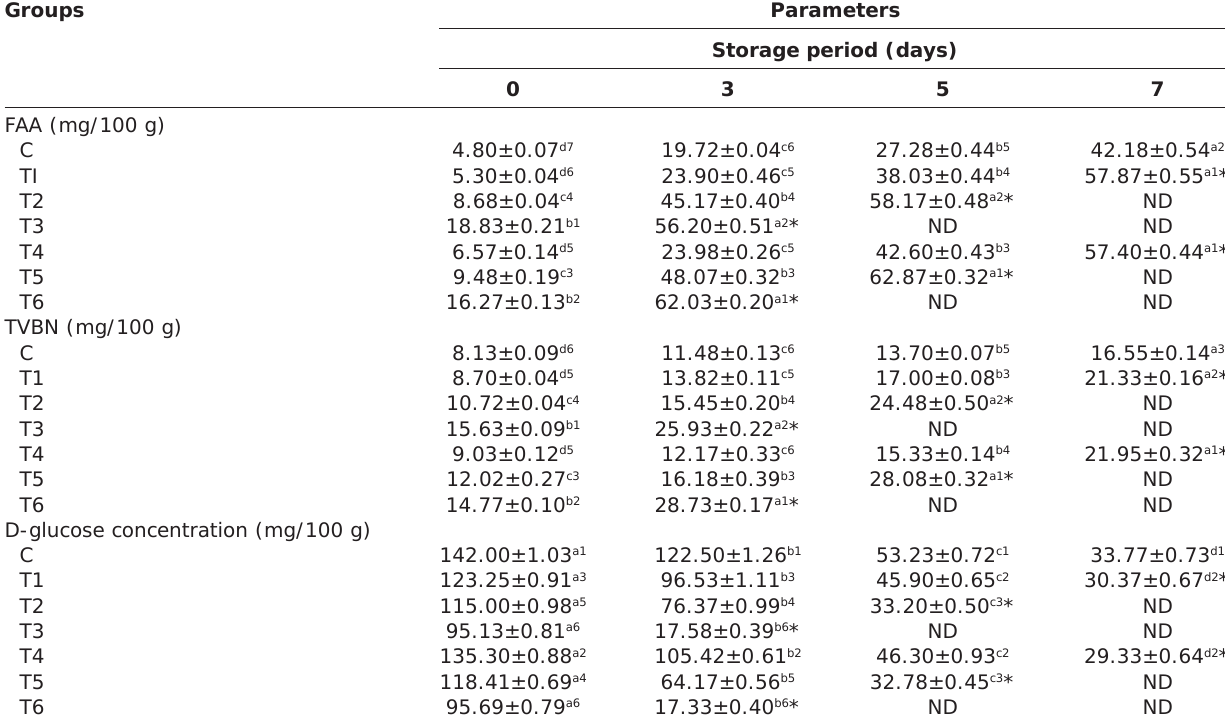
Table-2: FAA, TVBN and D-glucose content of control and treatment samples immediately after temperature exposure study and on subsequent refrigerated storage (mean±SE).